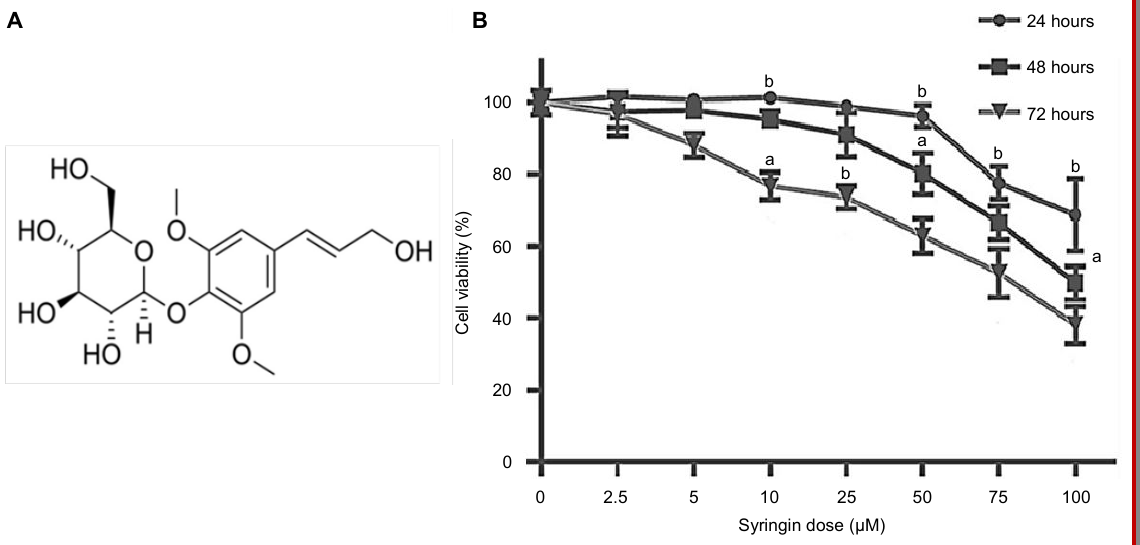
Figure 1: A: Chemical structure of syringin, B: Inhibition of cell growth induced by syringin in HeLa cervical cancer cells. Data are shown as the mean ± SD of three independent experiments. a p<0.05, b p<0.01 vs 0 µM (control)